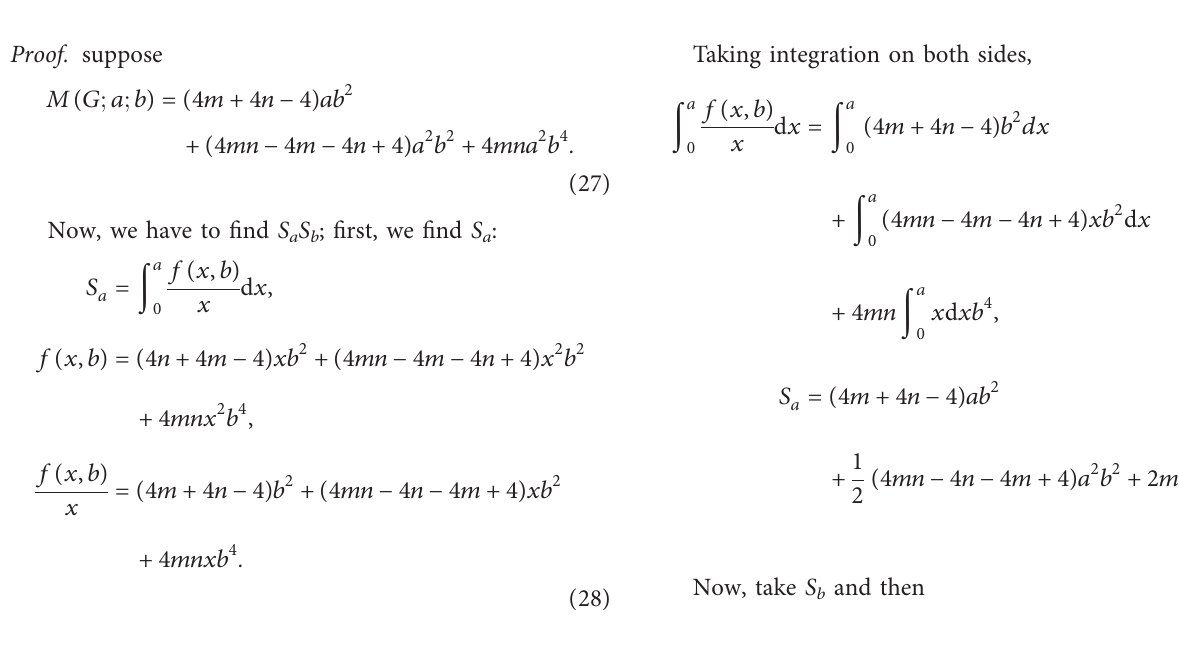
Figure 4: Second Zagreb index plotted in